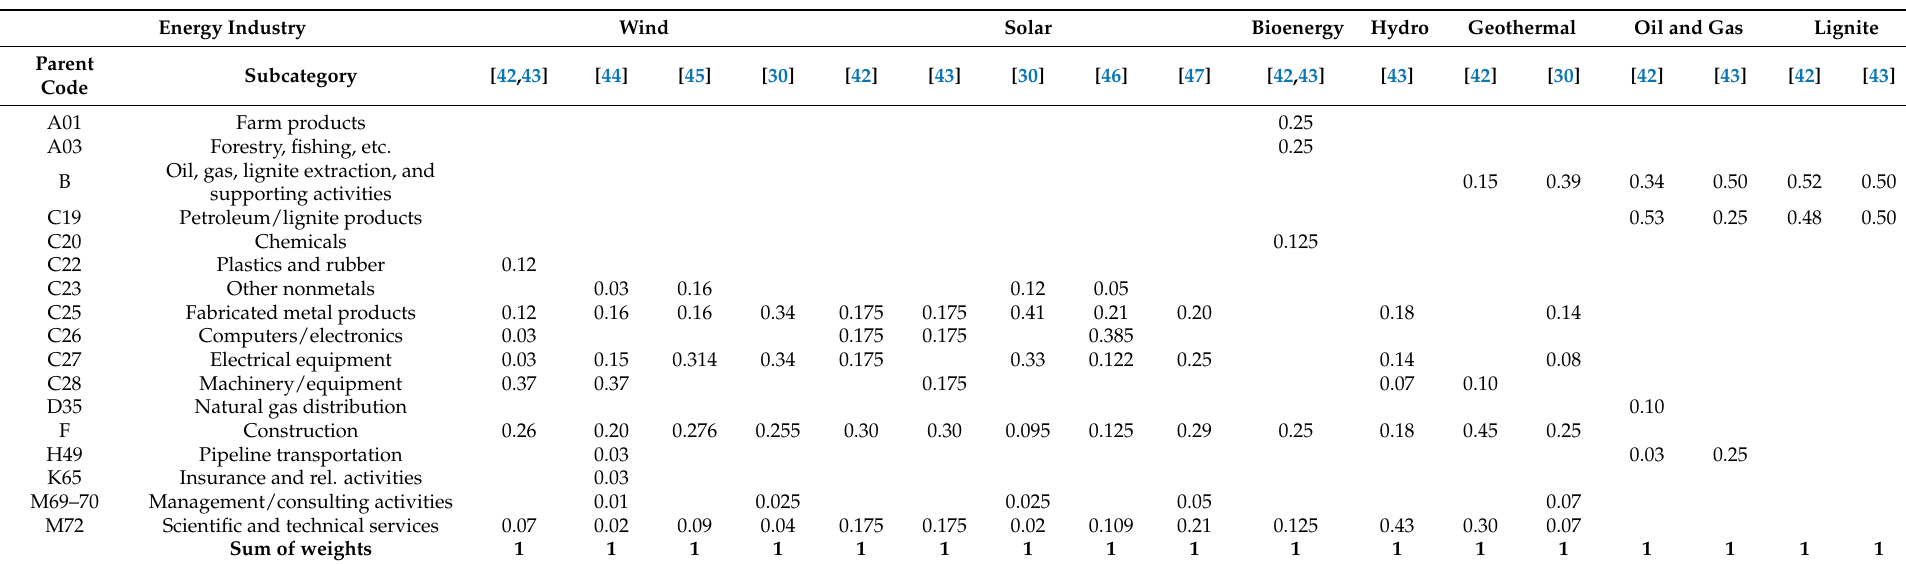
Table 4. Distribution of weights for the formation of demand vectors for the composite